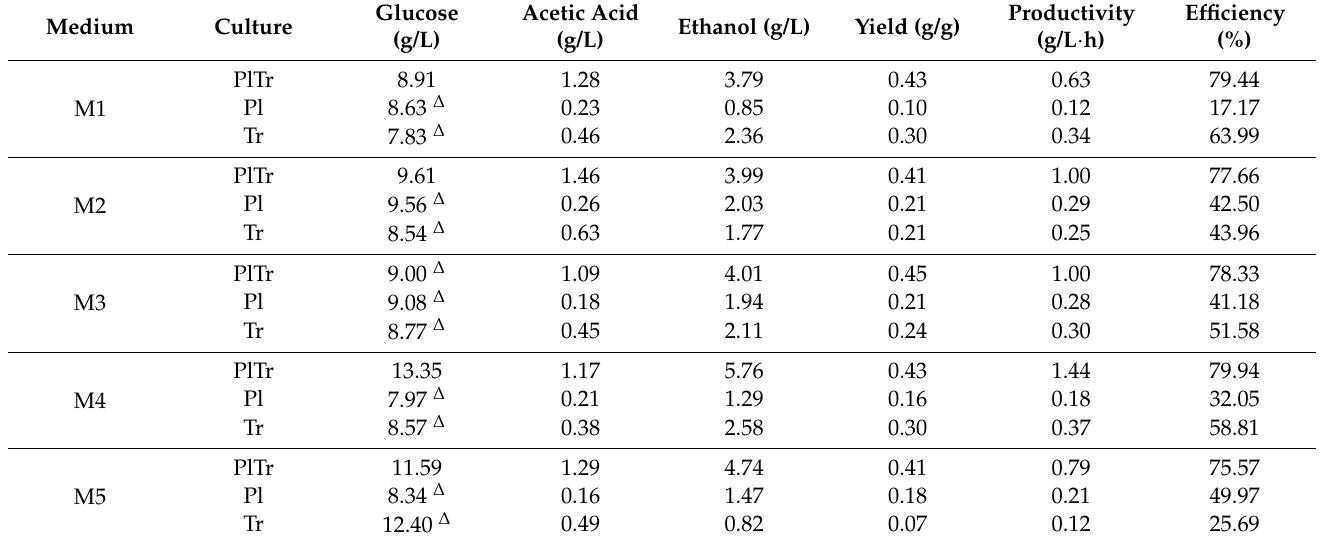
Table 4. Glucose and ethanol concentration (g/L), yield (g/g), productivity (g/L/h) and fermentation efficiency (%) of hydrolysates, obtained by hydrolysis of PSB using extracts from monocultures of P. lecomtei (Pl), T. reesei (Tr), and its co-culture (PlTr) obtained in cultures with the media M1, M2, M3, M4 and